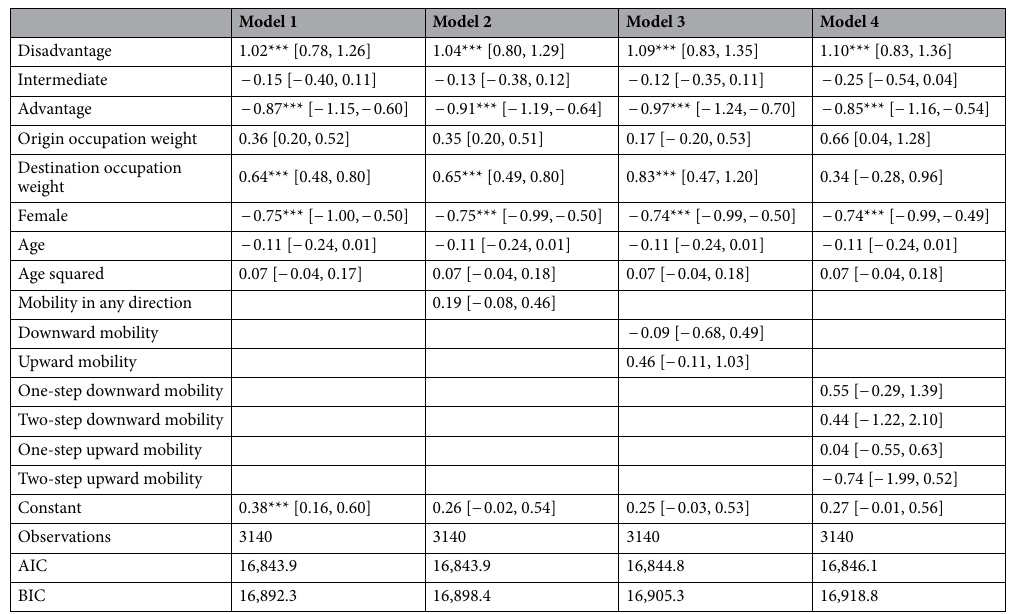
Table 6. DRM parameters estimation [95% confidence interval] for age acceleration indexed by DunedinPoAm algorithm. Notes: Models with covariates plus: (1) no mobility variable; (2) any direction mobility variable; (3) variables to indicate upward or downward trend; (4) variables to indicate one step, two step upward or downward trend. 95% confidence intervals in brackets. ***p <